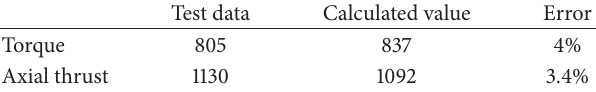
Table 1: The turbine torque and axial thrust